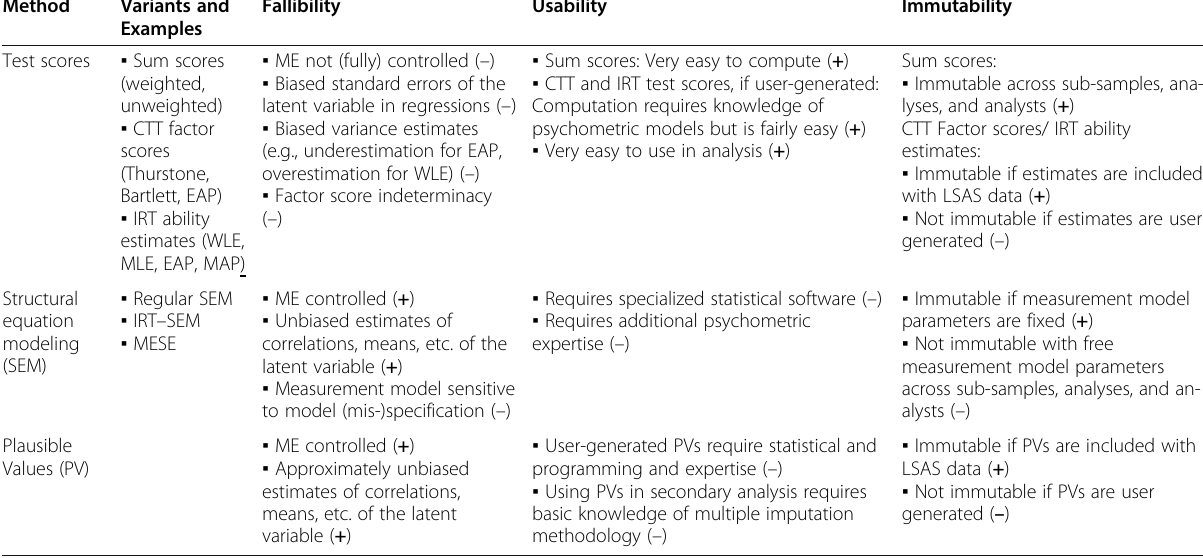
Table 1 Evaluation of the three main methods of using skill measures from LSAS